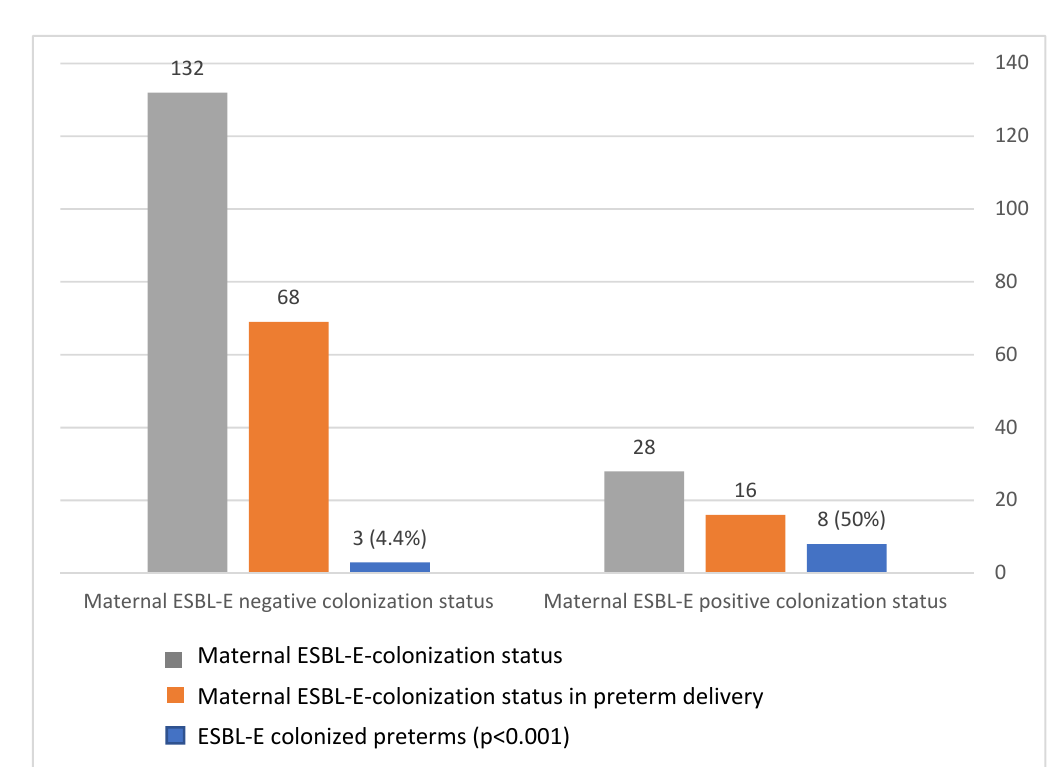
Figure 3. Extended-spectrum, beta-lactamase-producing Enterobacteriaceae (ESBL-E) transmission rate during preterm delivery.